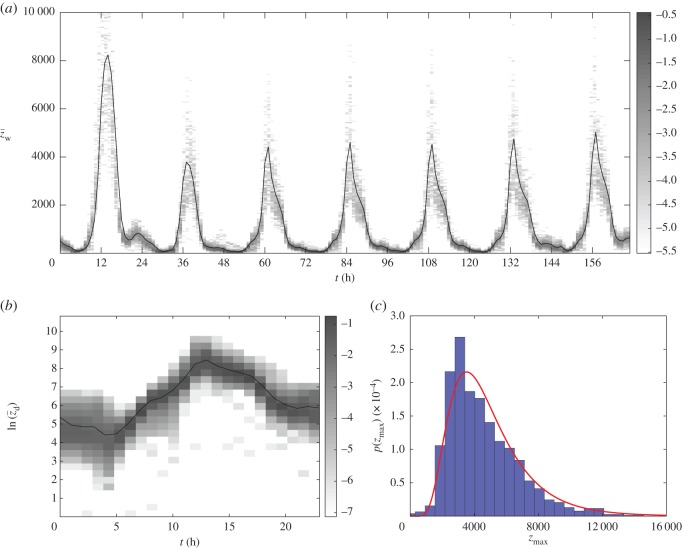
Statistics of Briggate footfall data. (a) The mean hourly counts from Saturday to Friday. (b) The mean hourly counts of just weekdays (Monday to Friday) together. (c) The distribution of peak daily counts and comparison with a lognormal distribution. More details are included in the main text.